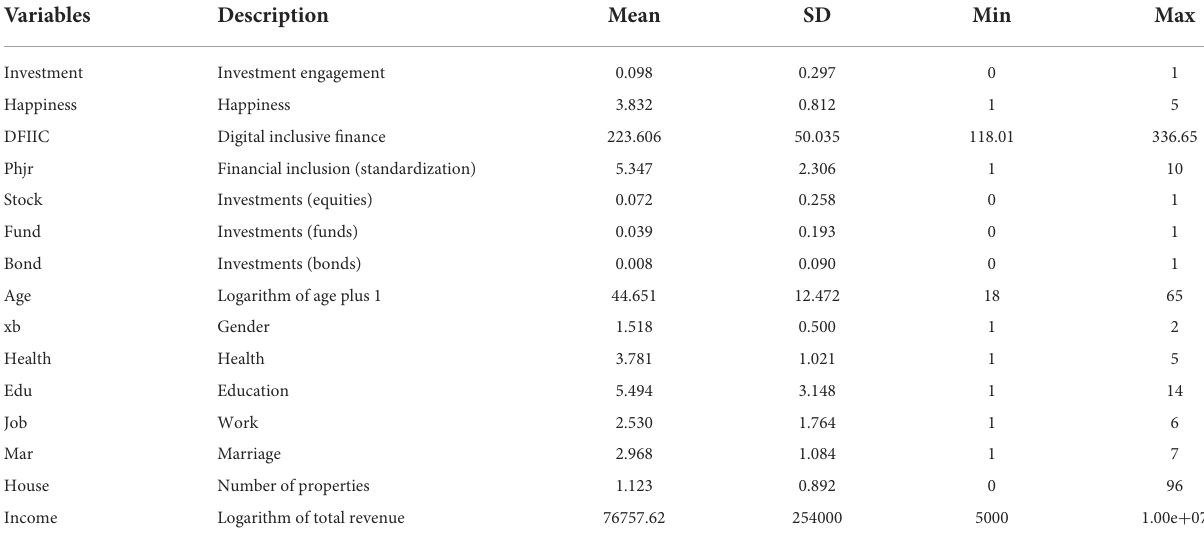
TABLE 1 Descriptive statistics of the main